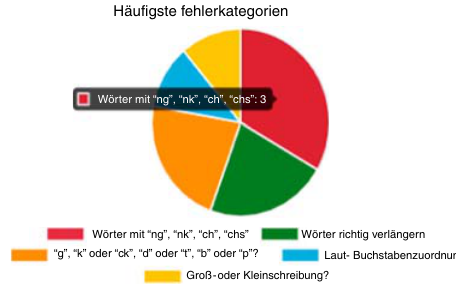
Figure 9. The top 5 error categories from the student are presented with a pie